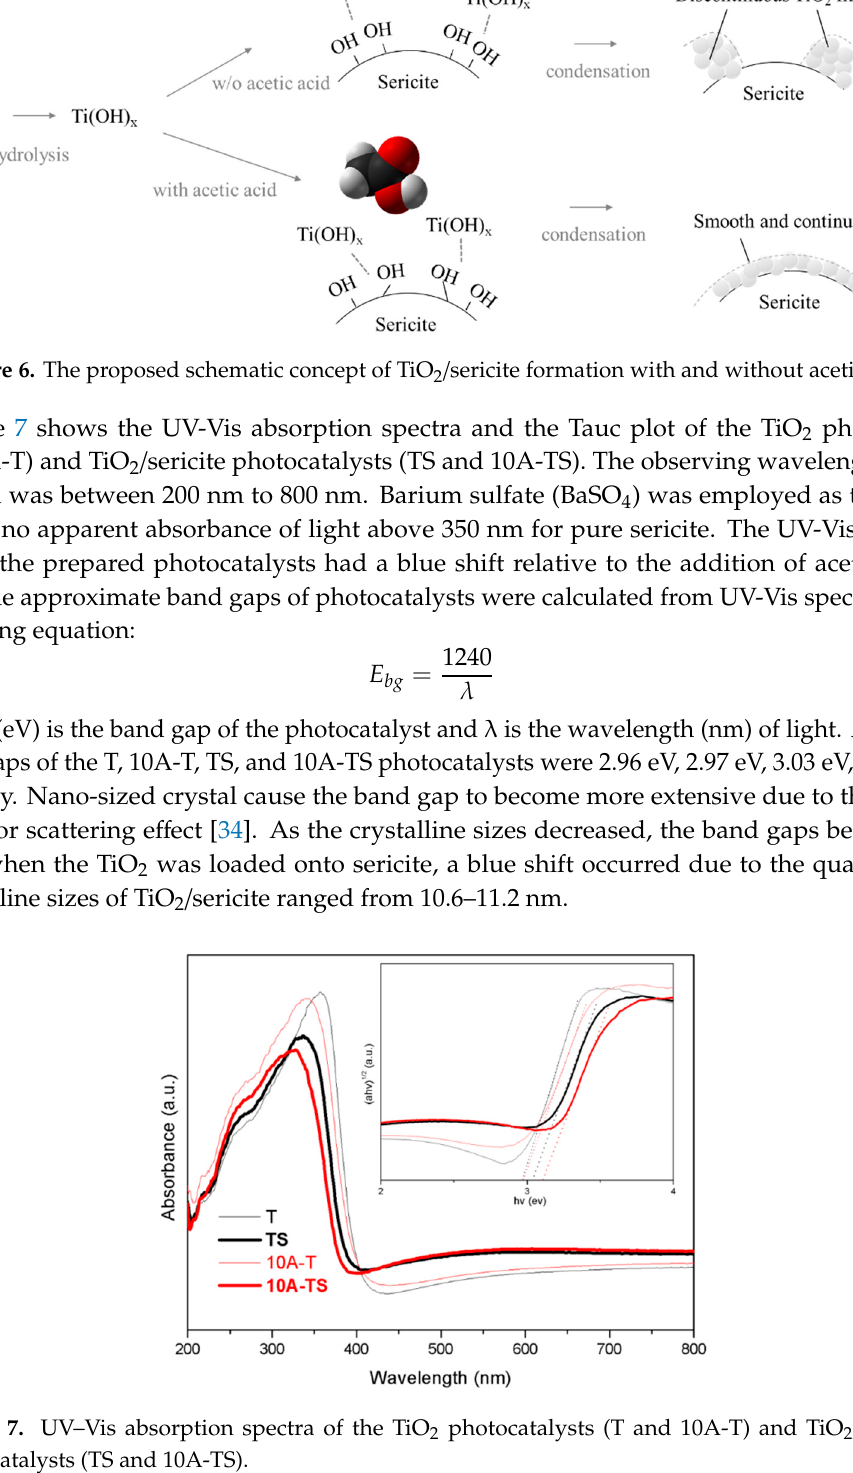
Figure 5. The proposed schematic concept of TiO 2 formation with and without acetic acid.